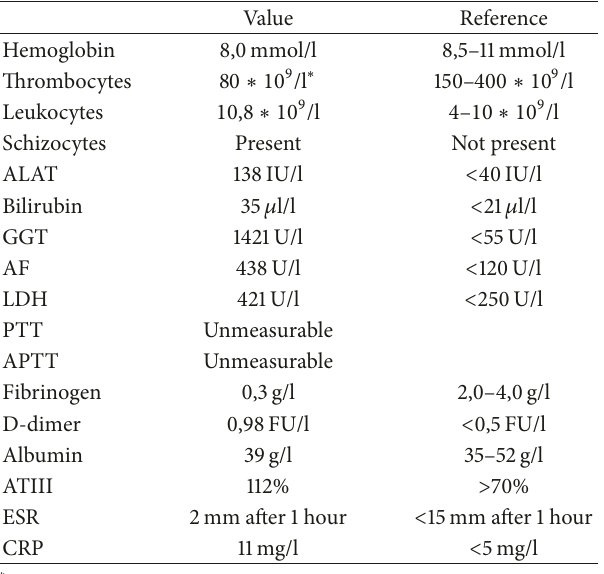
Table 1: Laboratory findings and blood drawn at admission.